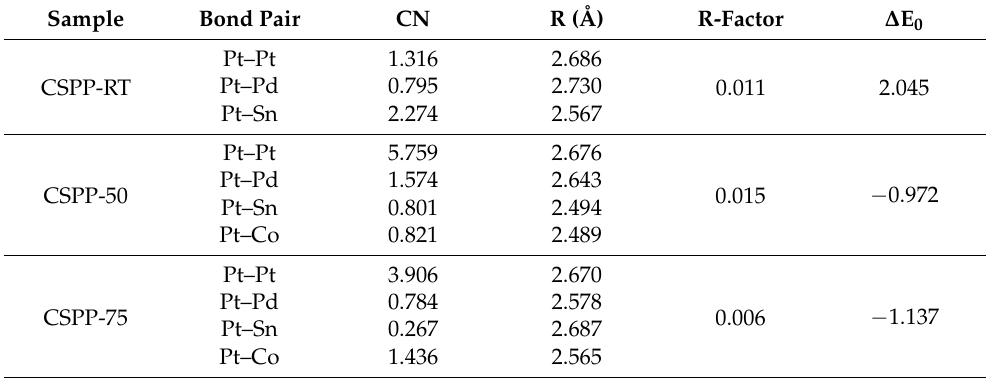
Table 1. The XAS model analysis determined structural parameters of CSPP NC.